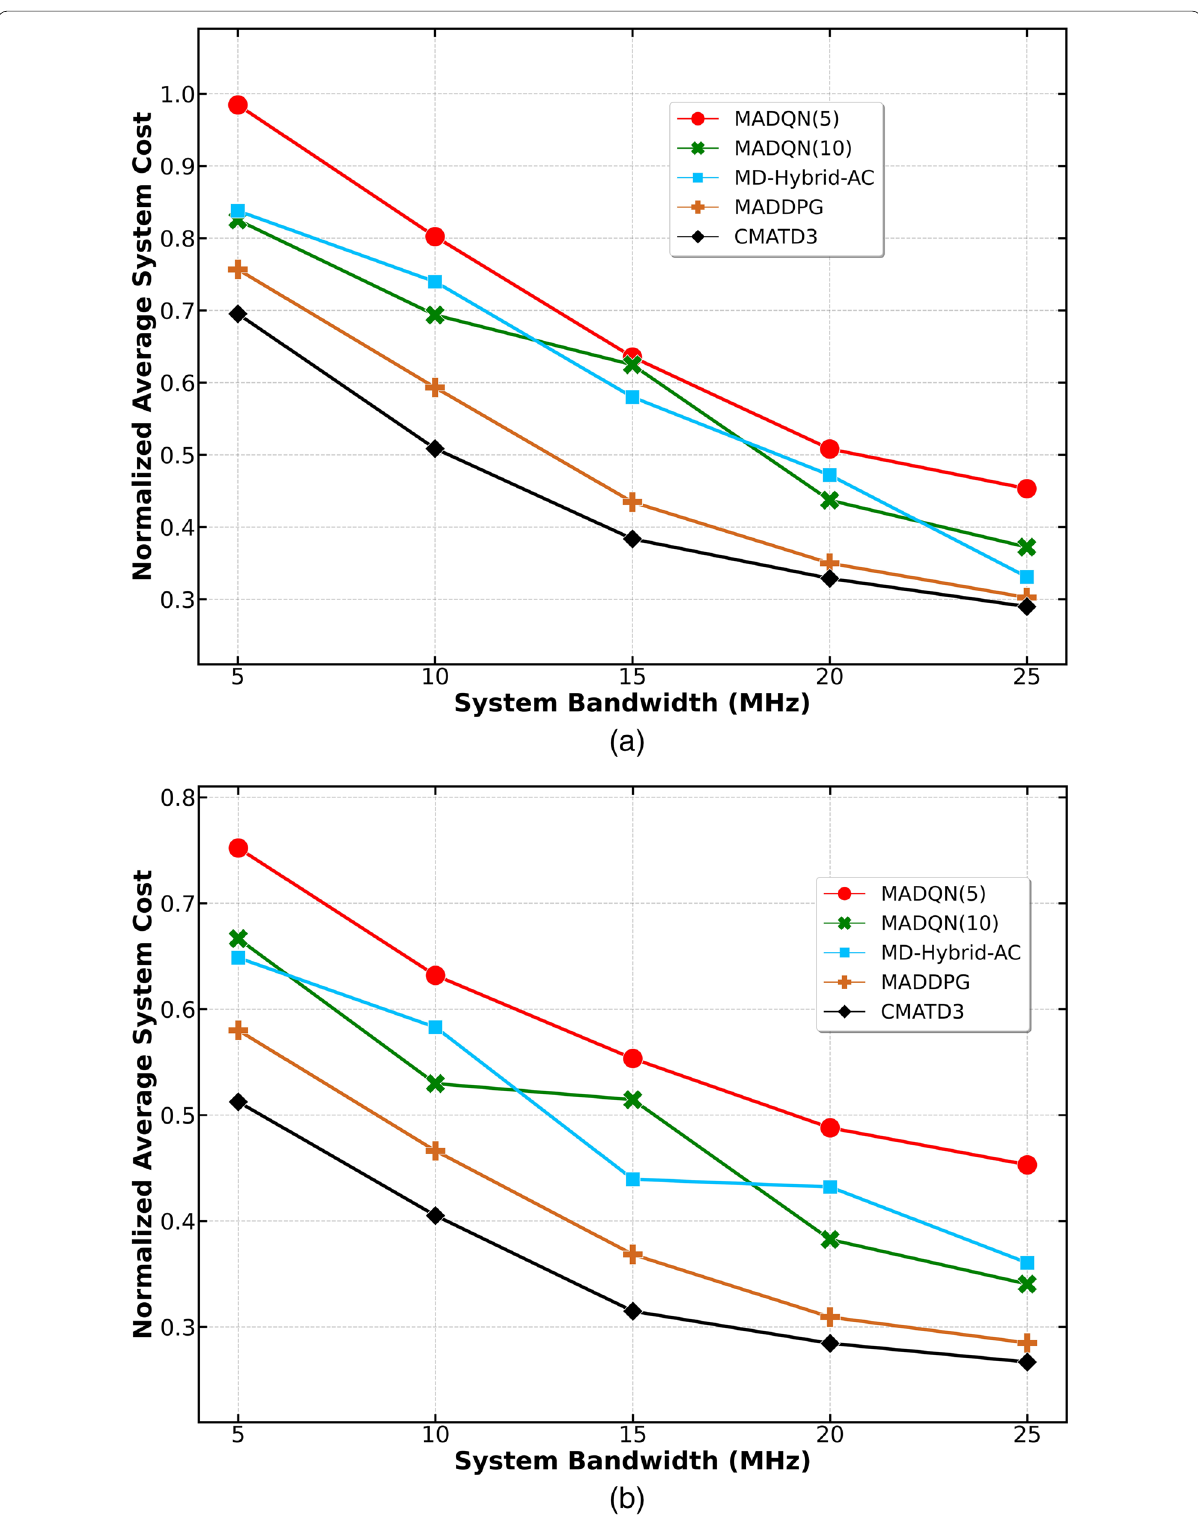
Fig. 9 Results of normalized average system cost vs. W with a the number of cloud server M = 2 and b the number of cloud server M =